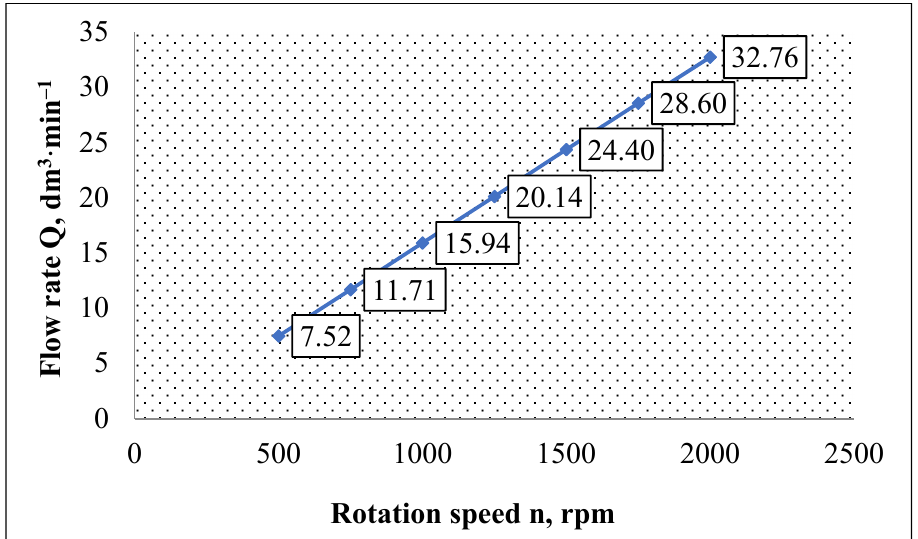
Figure 10. Flow characteristics of the transducers in the secondary circuit.